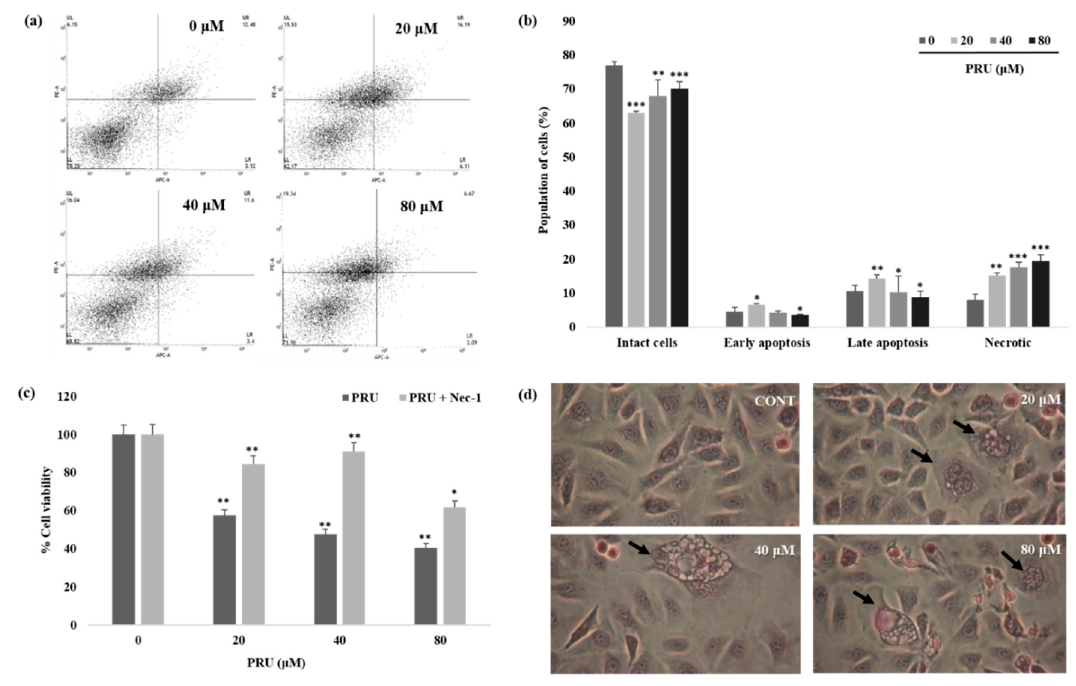
Figure 4. E ff ect of prunetin on necroptosis related cell death. ( a ) The e ff ect of PRU on cell cycle arrest was examined by flow cytometry analysis, AGS cells were treated with PRU at indicated concentrations (20, 40, and 80 µ M) for 24 h. Followed by allophycocyanin (APC) / annexin V and propidium iodide (PI) double-staining was performed which was analyzed by flow cytometry. ( b ) The population of cells identified on the di ff erent state of cell death were represented graphically. ( c ) Cell viability assay performed on PRU treated AGS cells with and without co-treatment with necrostatin-1 inhibitor (0.1 mM). ( d ) Hematoxylin staining on PRU treated AGS cells with visible necroptic morphology such as cell swelling, visible disruption of cell organelles, and formation of vacuoles. Values are given as the mean ± standard error of the mean (SEM) of three independent experiments. * p < 0.05 vs. control, ** p < 0.01 vs. control, *** p < 0.001 vs. control.